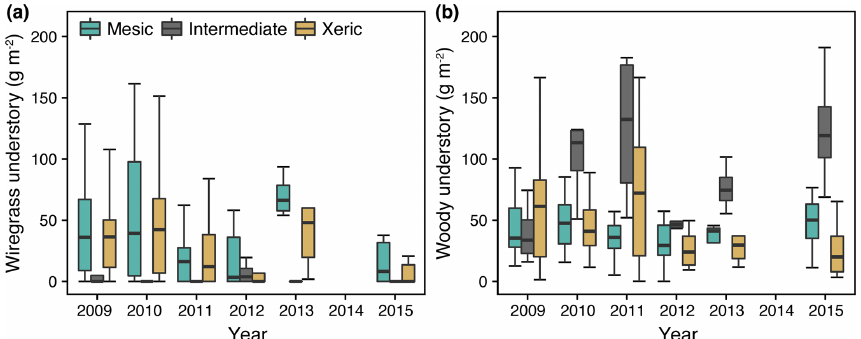
Figure 4. (a) Wiregrass and (b) woody understory biomass from 2009 through 2015 at the mesic, intermediate and xeric sites. Note that the sampling protocol changed to a 2-year measurements cycle in 2013, such that measurements were not made in 2014 and 2016.